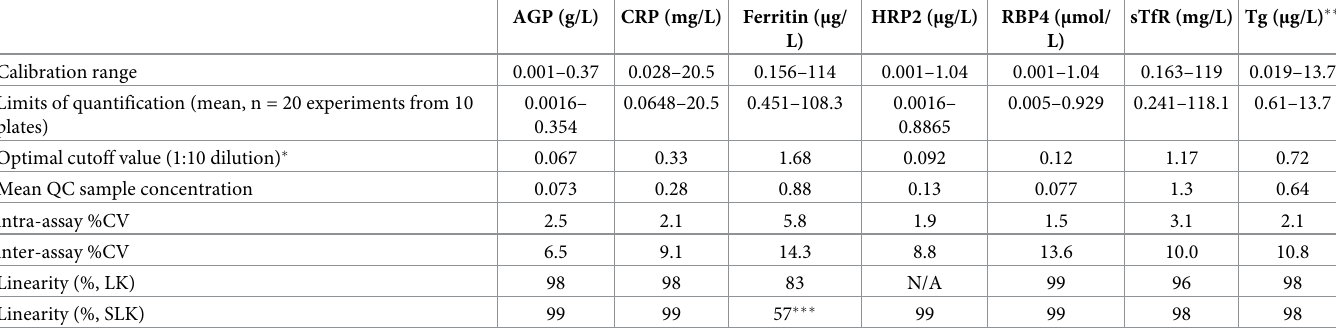
Table 1. Analytical validation of 7-plex